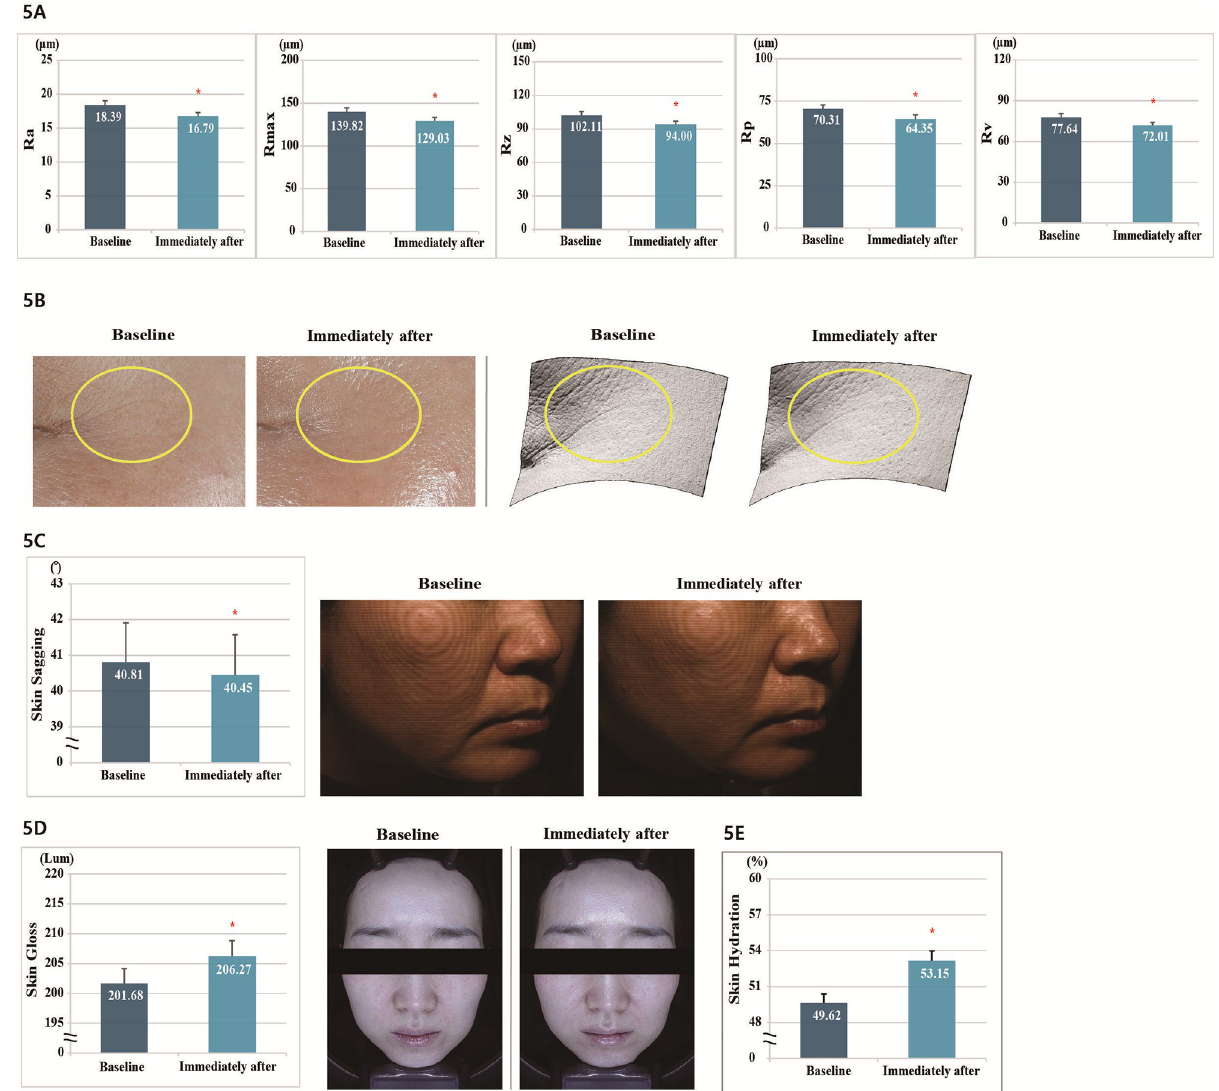
Fig 5. (A) Measurement of Ra, Rmax, Rz, Rp, and Rv parameters for fine wrinkles around the eyes. (B) Polarized and 3D images of wrinkles around the eyes after one use of the product. (C) F-RAY the facial contour line image of the right cheek area after using the product once. (D) Effect of a single use of the product in improving the facial gloss and polarized image of skin gloss after a single use of the product. (E) Facial moisturizing effect after using the product